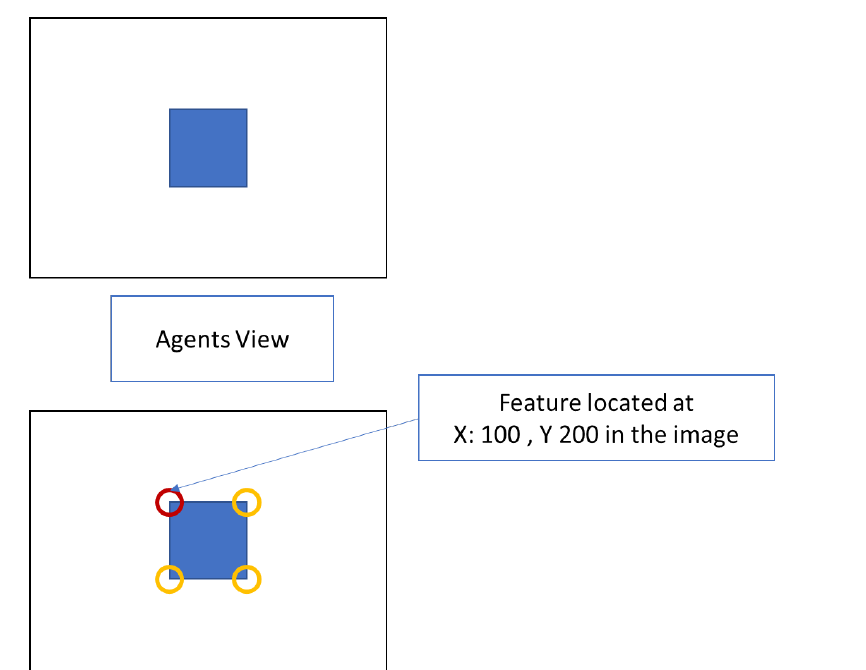
Figure 15. Figure showing features detected from agent’s